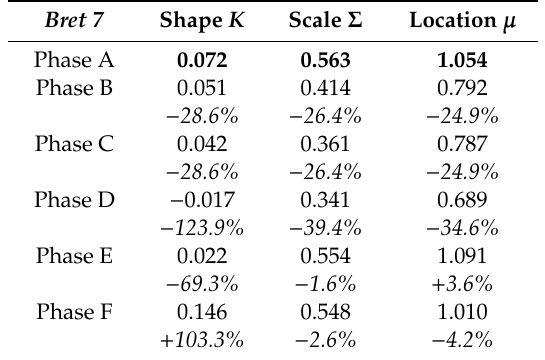
Table 8. The generalised Pareto (GP) distribution parameter values for di ff erent phases of testing.